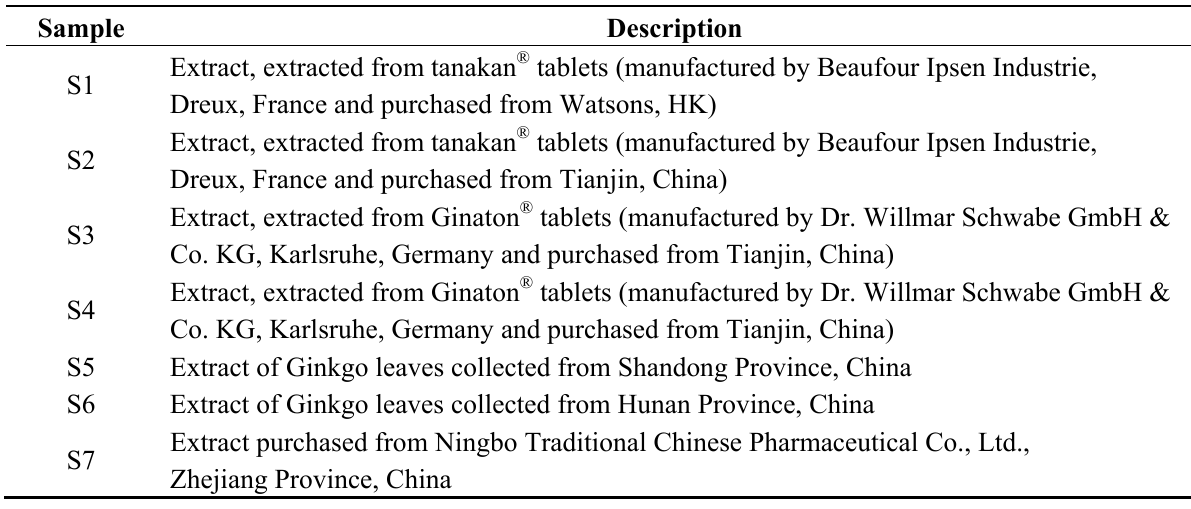
Table 4. Samples for quantitative